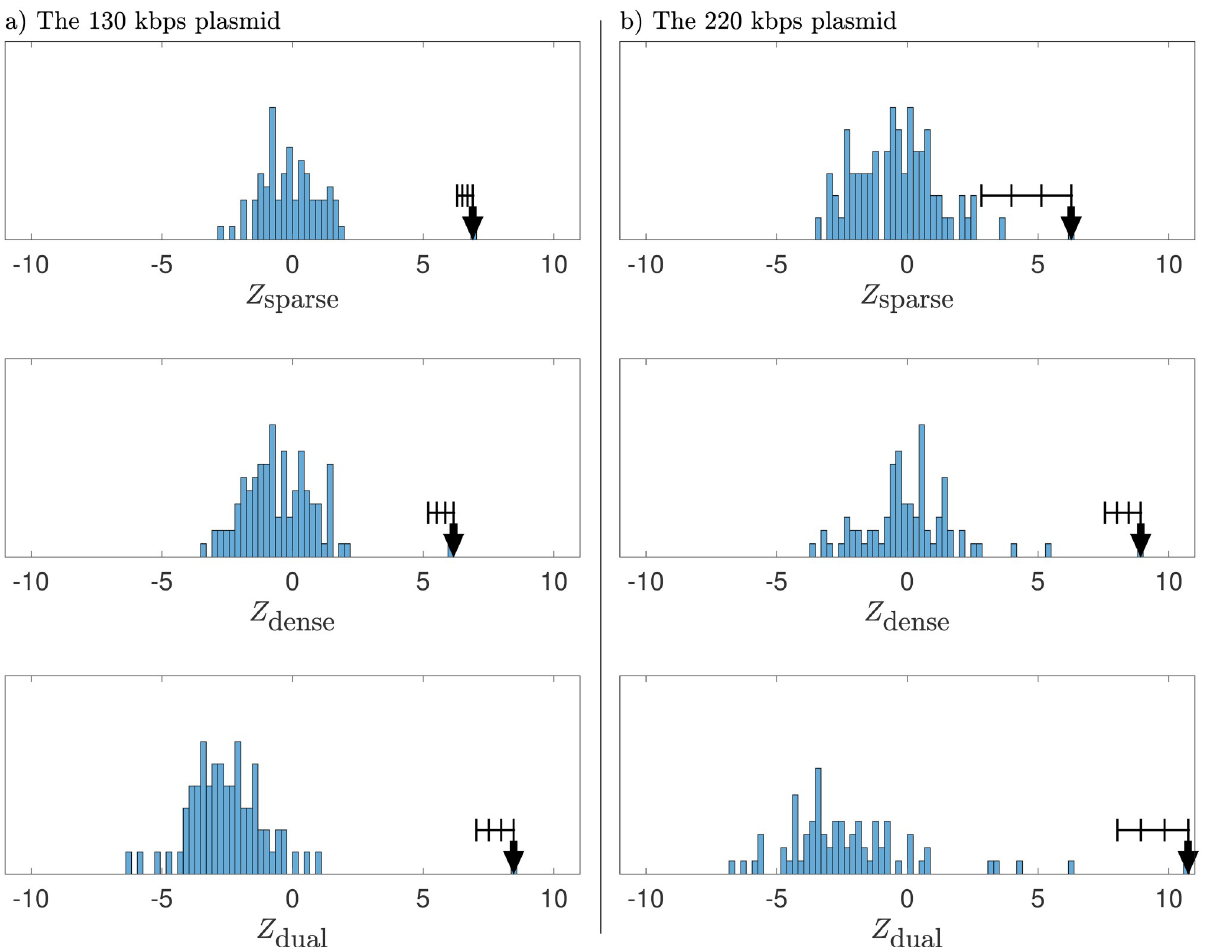
Fig 6. Match scores for the two plasmid barcodes against the plasmid barcode database. Histograms of match scores are obtained by comparing experimental dually labeled barcodes in Figs 4 and 5 against all theoretical barcodes in the plasmid barcode database. The histograms show match scores for each barcode type (top row = CB labeling, middle row = cut-labeling) as well as the combined match-score (bottom row). The arrows indicate the match scores at the optimal align position with respect to the combined match score. The error bars represent the uncertainty in the maximum match-scores as estimated by the bootstrap resampling procedure described in sec 2.5. For the 130 kbps plasmid, the p-values are P sparse = 2.8 � 10 − 12 , P dense = 3.7 � 10 − 10 , P combined = 1.4 � 10 − 17 . For the 220 kbps plasmid the p-values are P sparse = 1.8 � 10 − 10 , P dense = 2.3 � 10 − 19 , P combined = 3.3 � 10 − 27 . A quantitative measure of the uniqueness-of-match of the top case is how many, X , standard deviations ( σ Z ) there is between the Z -values for the top and second-best case. For the 130 kbps plasmid, we have X sparse = 25.0, X dense = 13.0, P combined = 16.0. For the 220 kbps plasmid, we find X sparse = 2.3, X dense = 7.7, X combined =